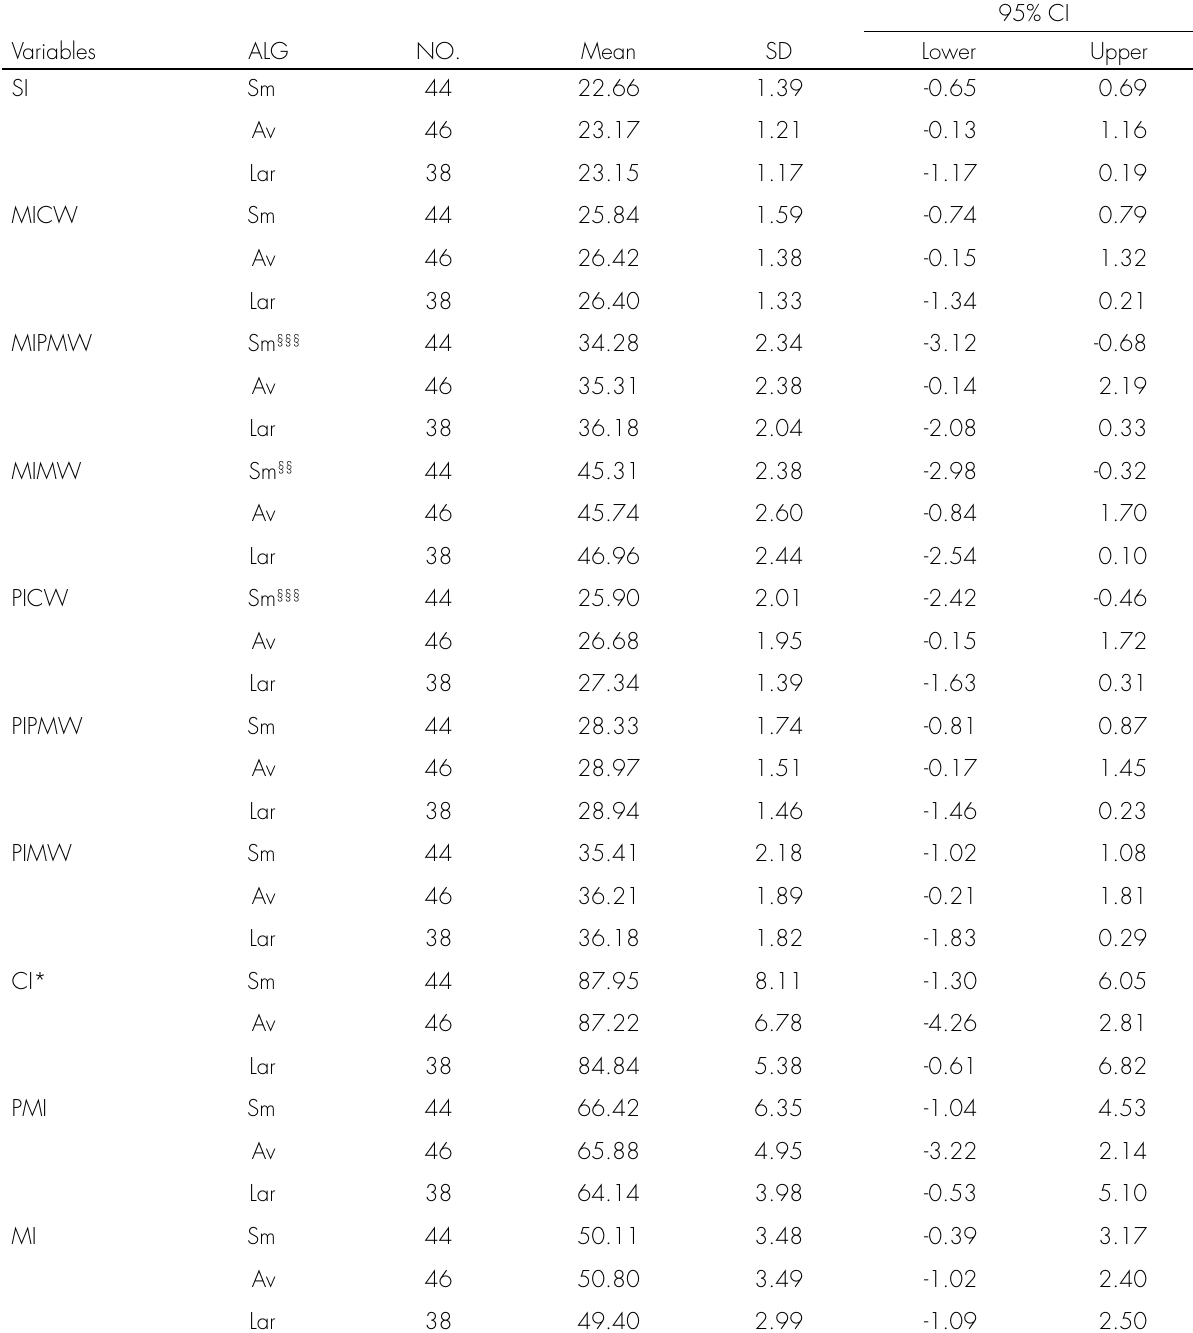
Table IV. Comparison of the sum of the incisors, arch width and expansion indices in relation to various arch length groups (ALG) of the mandibular